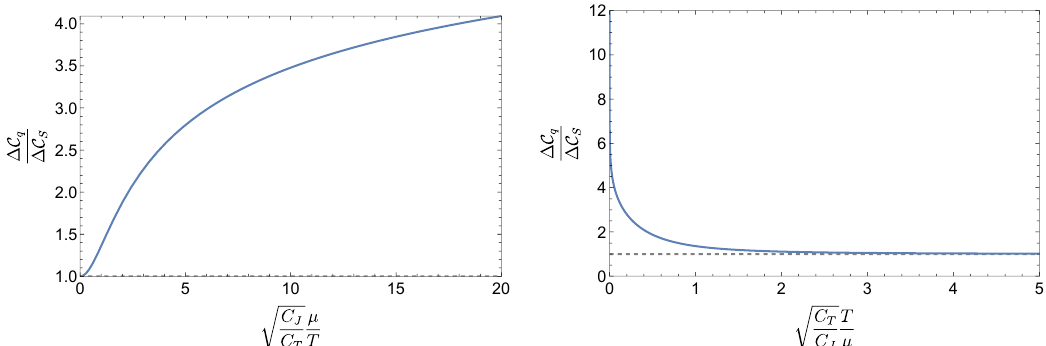
Figure 28 . Complexity of formation from the CV conjecture normalized by (cid:1) C S for planar ( k = 0) charged black holes in d = 4 as a function of the dimensionless ratio of boundary quantities q (cid:22) C J (cid:23) (cid:17) and its inverse. Extremal black holes ( T = 0) have divergent complexity of formation C T T also using the CV conjecture.